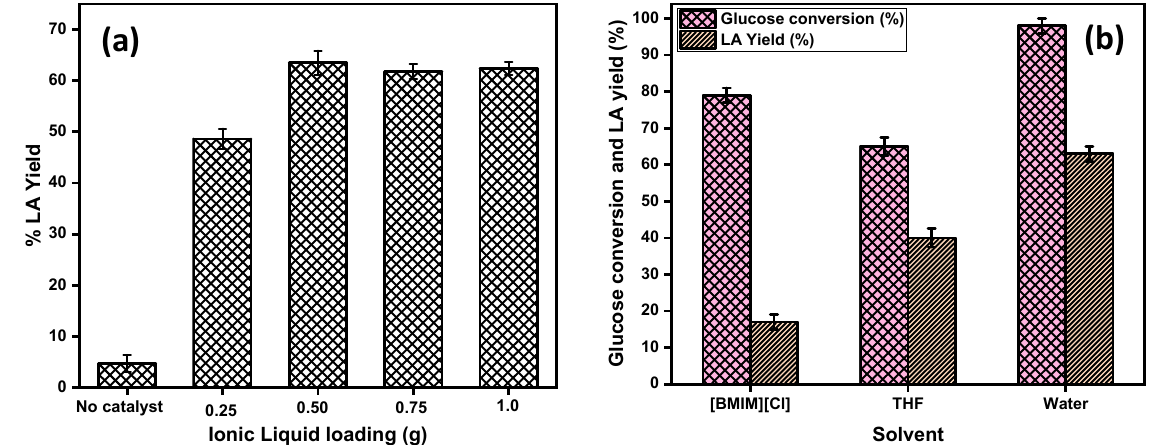
Figure 5. ( a ) Effect of the ionic liquid loading on the product yield; reaction conditions: 100 mg glucose, 2.0 mL of water, temp = 180 °C. ( b ) Effect of the solvents on the glucose conversion and LA yield; reaction conditions: 100 mg glucose, 2.0 mL solvent, t = 3 h, temp = 180 °C, catalyst [C 4 SO 3 HPhim][Cl] = 500 mg.